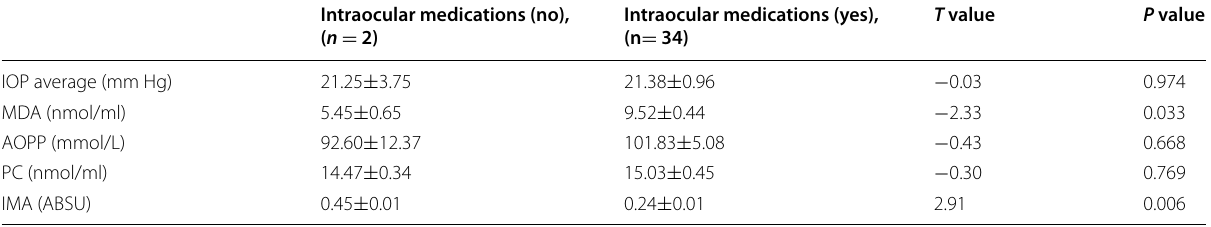
Data are expressed as mean